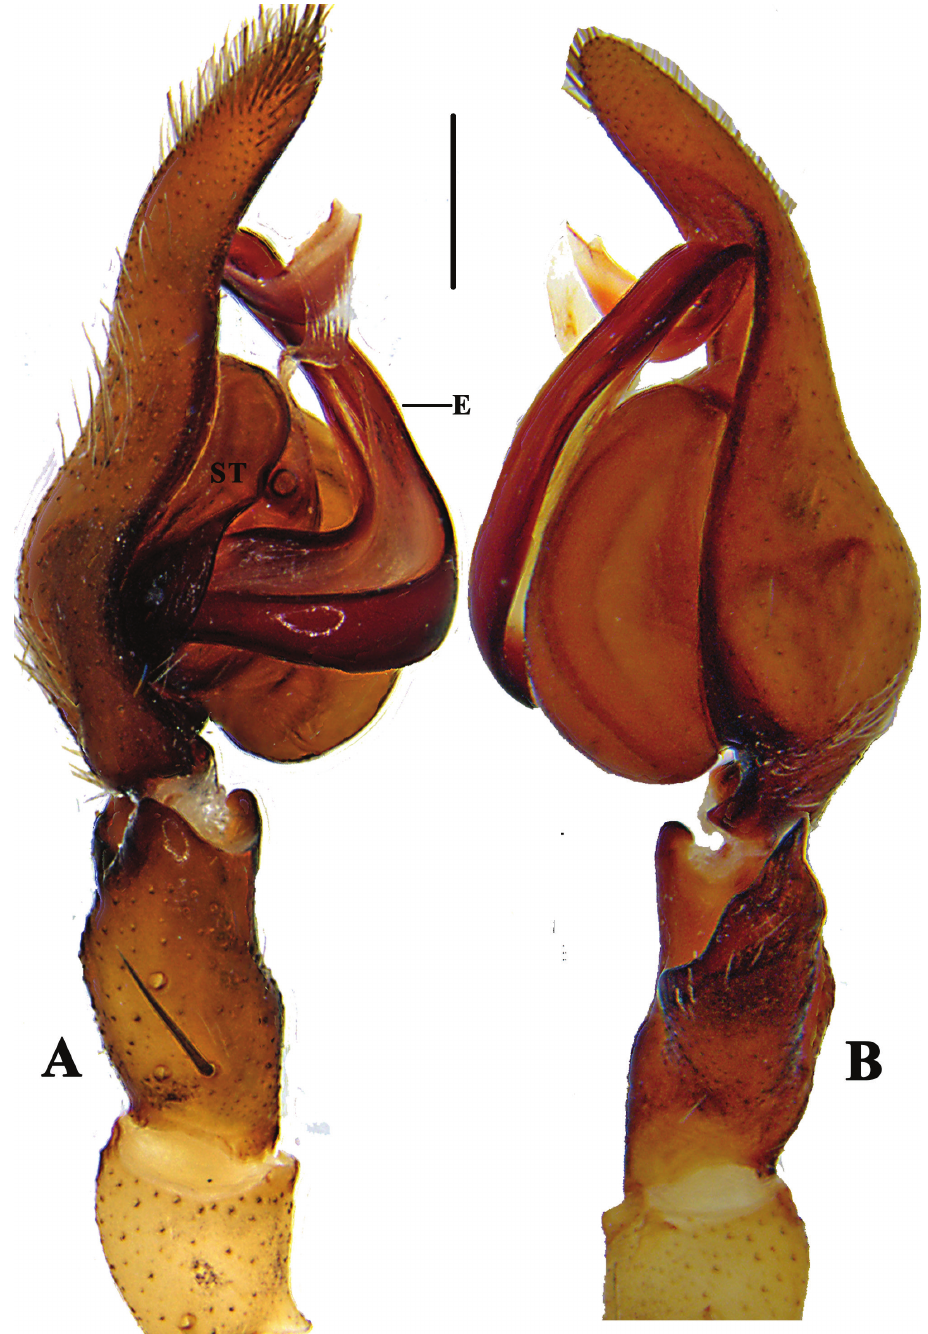
Figure 9. Pseudopoda semilunata sp. nov. A left male palp, prolateral B Same, retrolateral. Abbreviations: E-embolus; ST-subtegulum. Scale bar: 0.5